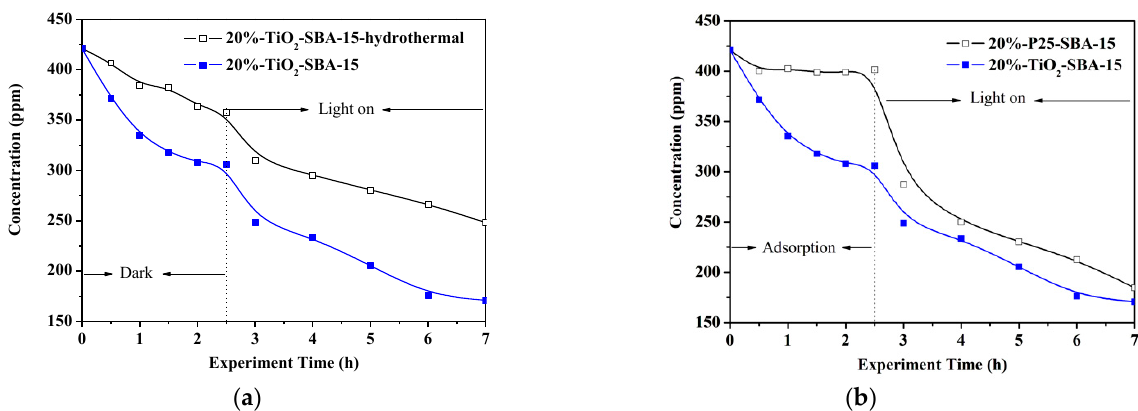
Figure 8. The photocatalytic performance curve of different TiO 2 loading catalysts degrading tolu- ene, ( a ) concentration of toluene for removal process, ( b ) removal ratio of toluene for removal pro- cess.